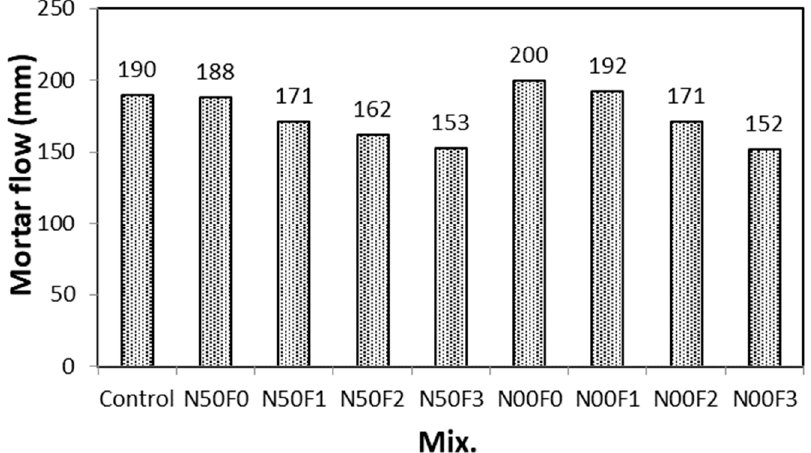
Figure 4. Mortar flow values for different aggregate mixtures.